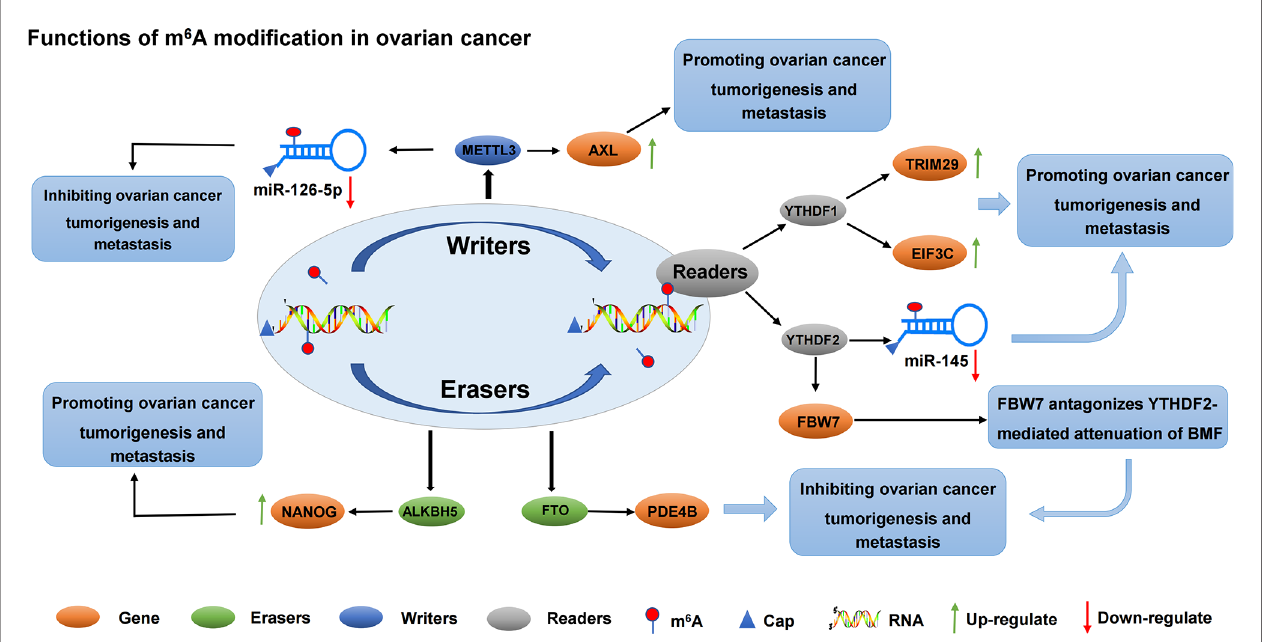
FIGURE 4 | The roles of different m 6 A regulators in regulating RNAs in ovarian cancer. m 6 A methylation regulators METTL3, YTHDF1, YTHDF2, FTO and ALKBH5 promote/inhibit the invasion and metastasis of ovarian cancer by binding to mRNA and regulating mRNA expression. In addition, METTL3 regulates the expression of miR-126-5P and inhibits the proliferation and metastasis of ovarian cancer. YTHDF2 regulates the expression of miR-145 and promotes the proliferation and metastasis of ovarian cancer.